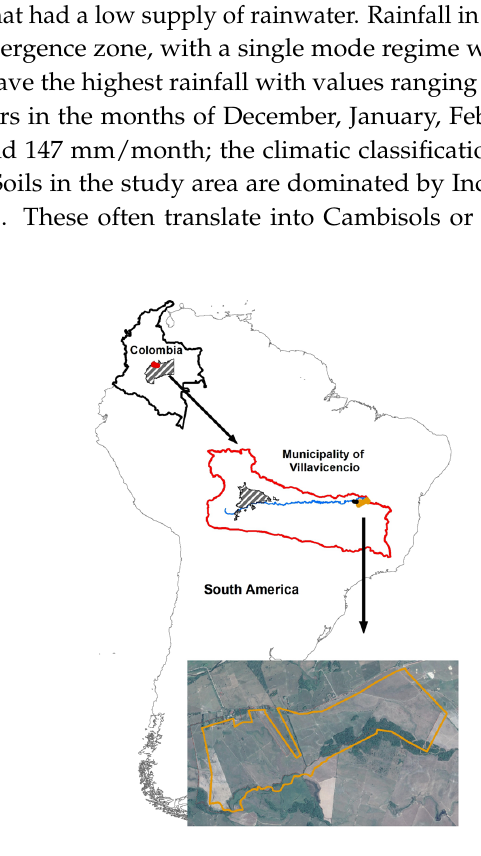
Municipality of Villavicencio within the department of Meta (stripped pattern), the red outlined area